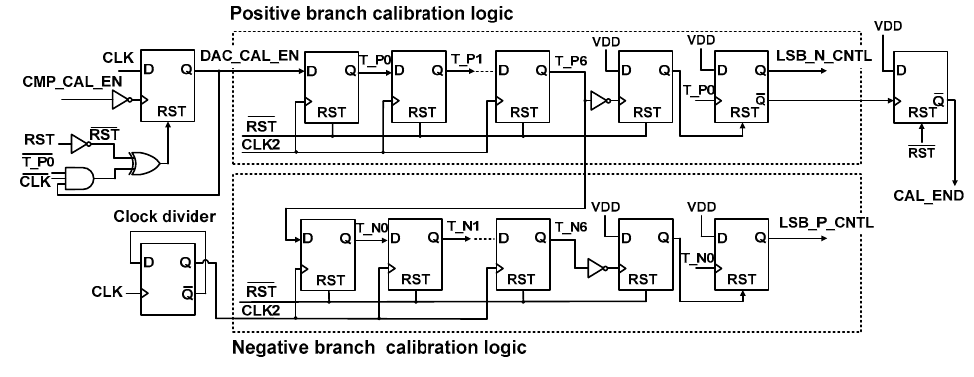
Figure 11. Schematic of the DAC calibration logic.